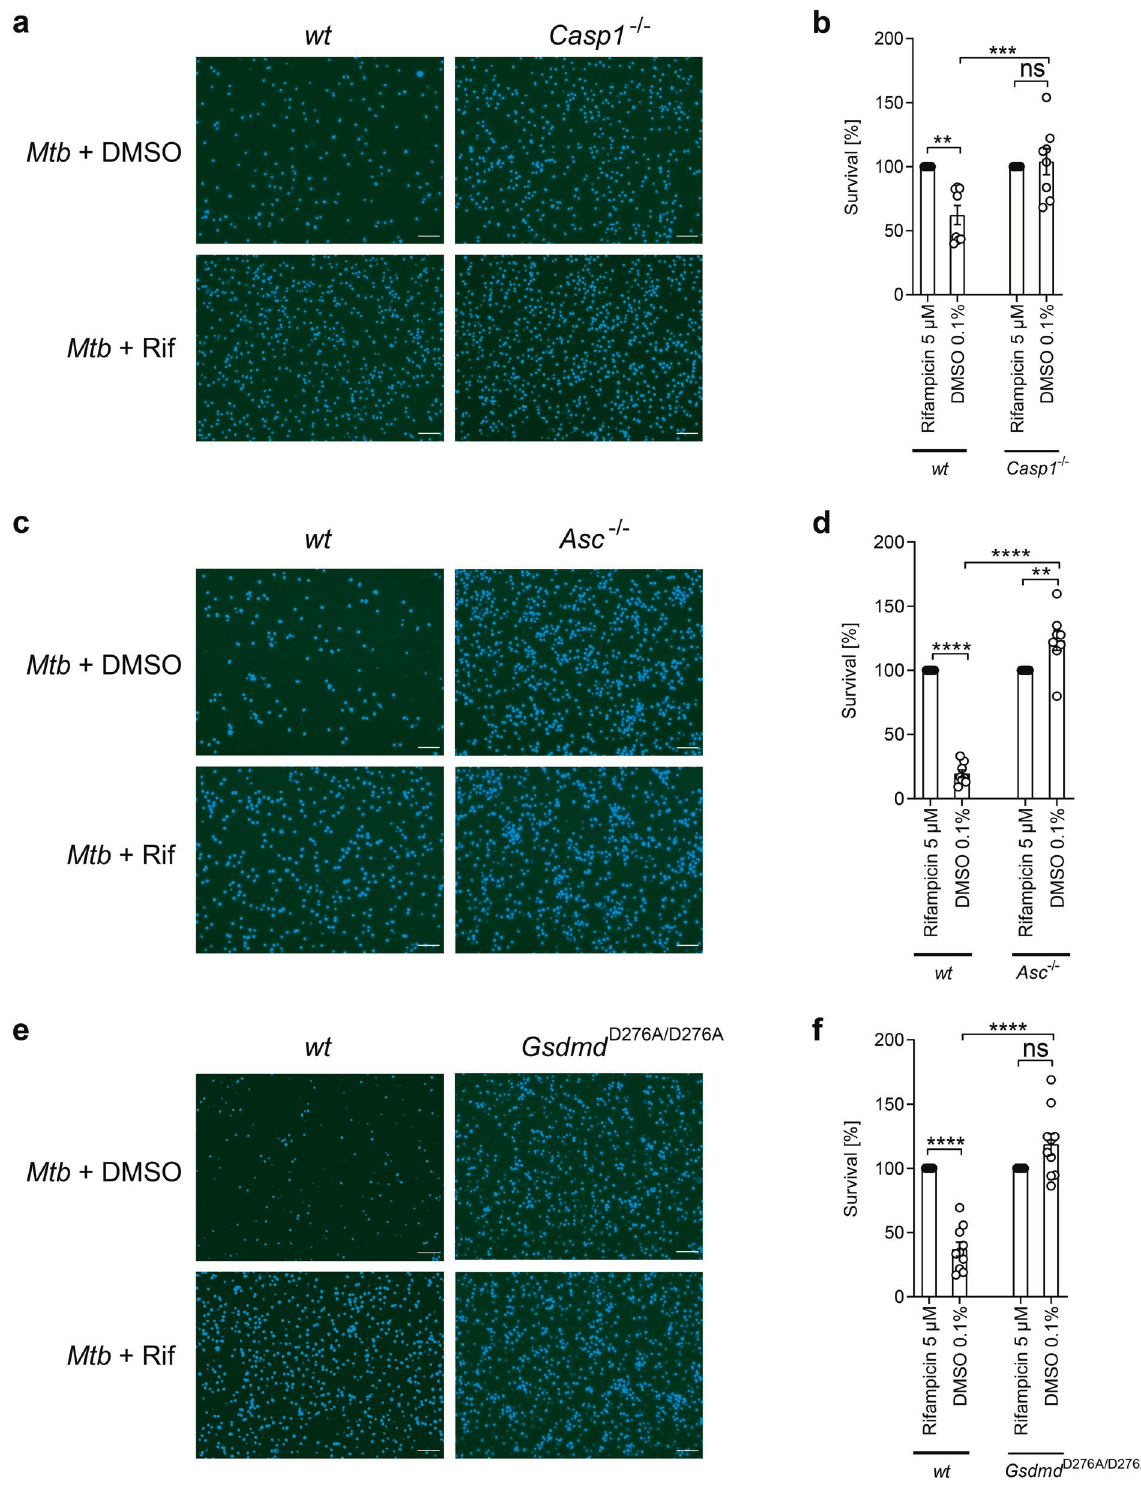
Fig. 4 Mtb infection induces caspase-1 activation. Survival of BMDM isolated from wild-type ( wt ) and a , b caspase-1 knockout ( Casp1 − / − ) mice ( n = 8), c , d apoptosis-associated speck-like protein containing a CARD knockout ( Asc − / − ) mice ( n = 8) or e , f gasdermin D ( Gsdmd D276A ) mice ( n = 10) infected with Mtb (MOI 3) was determined 48 h post infection using DAPI staining (scale bar: 100 μ m). Data from two experiments with multiple replicates are shown in a – f . Results are expressed as mean ± SEM. Analysis was done using one-way ANOVA with Bonferroni post-test (ns, not signi fi cant; ** p ≤ 0.01; *** p ≤ 0.001; **** p ≤ 0.0001).